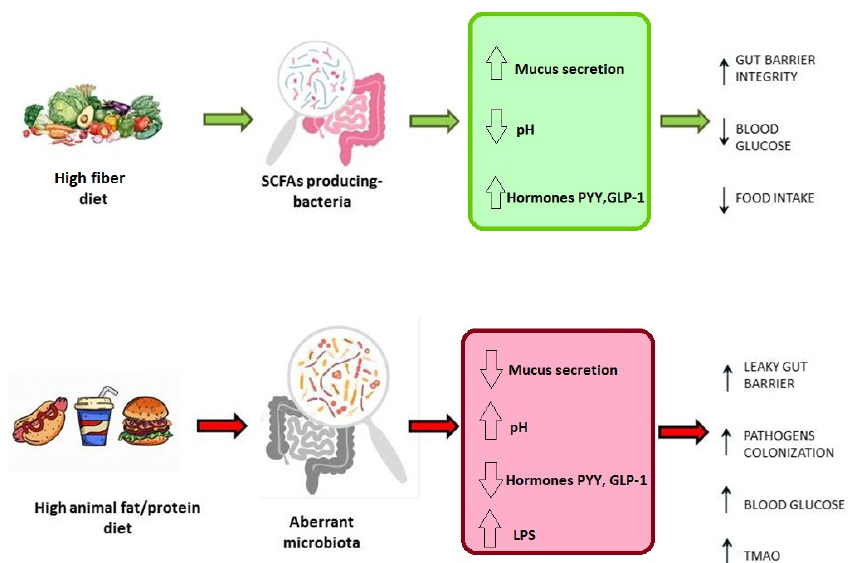
Figure 2. Impact of diet on intestinal microbiota and health outcomes. SCFA = short chain fatty acids; PYY = peptide YY; GLP-1 = glucagon-like peptide 1; LPS = lipopolysaccharide; TMAO = trimethylamine N ‐ oxide.